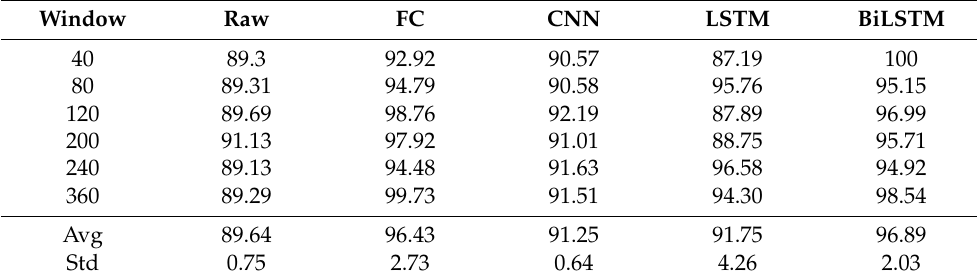
Table 12. Accuracy obtained by the unsupervised classifiers: Adjusted Mutual Information.